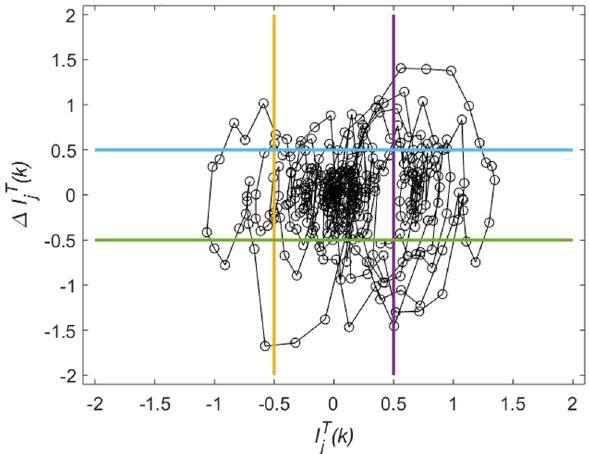
Figure 6: Nonlinear scaling for the new con fi rmed cases in Finland: scaling function ( upper curve ) and derivative ( lower curve ) .